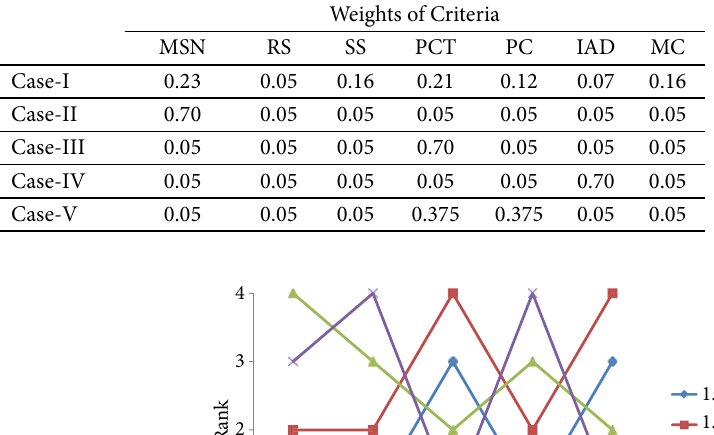
Table 18. The cases considered for sensitivity analysis